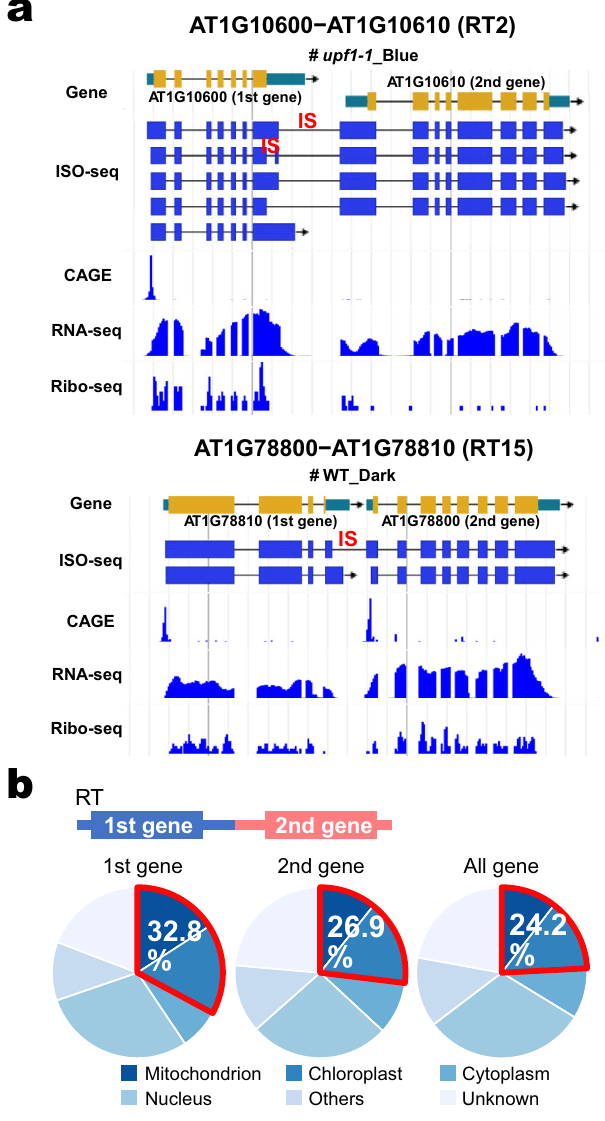
Fig. 1 Identi fi cation of readthrough transcripts (RTs) in young Arabidopsis seedlings by long-read sequencing. a Example display of two RT loci (AT1G10600-AT1G10610 (RT2) and AT1G78800-AT1G78810 (RT15)). IS = intergenic splicing. b Localization prediction of products of the fi rst and second genes of the 271 identi fi ed RT loci and all